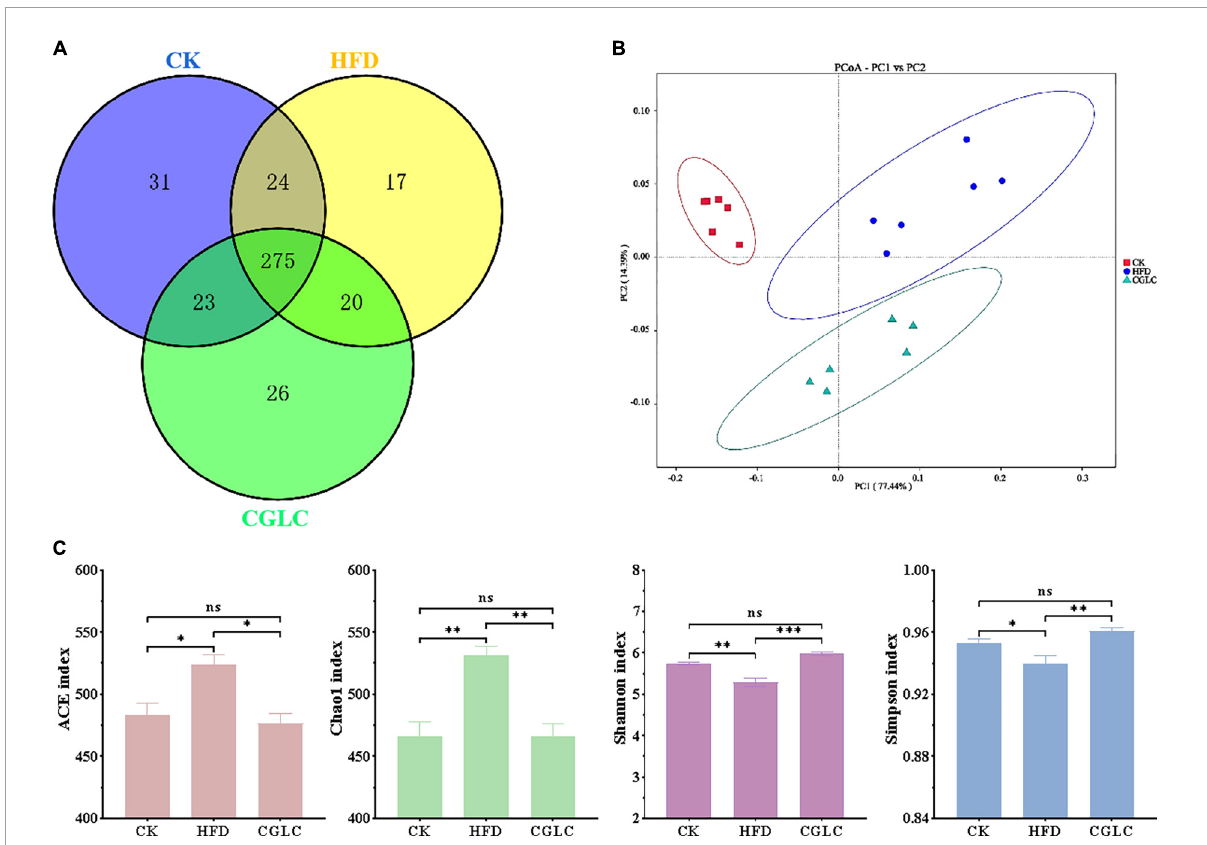
FIGURE3 Analyses of CGLC on diversity and richness of the gut microbiota. Venn graph showing the OTU numbers of gut microbiota from three groups (A) . Weighted UniFrac PCoA analysis of gut microbiota on the basis of three group OTU data (B) . Analysis of alpha-diversity [abundance coverage-based estimator (ACE), Chao1, Shannon, and Simpson indices] in each group (C) . ns, no significant difference; ∗ , significant difference ( P < 0.05), ∗∗ and ∗∗∗ , highly significant difference ( P < 0.01 and P <